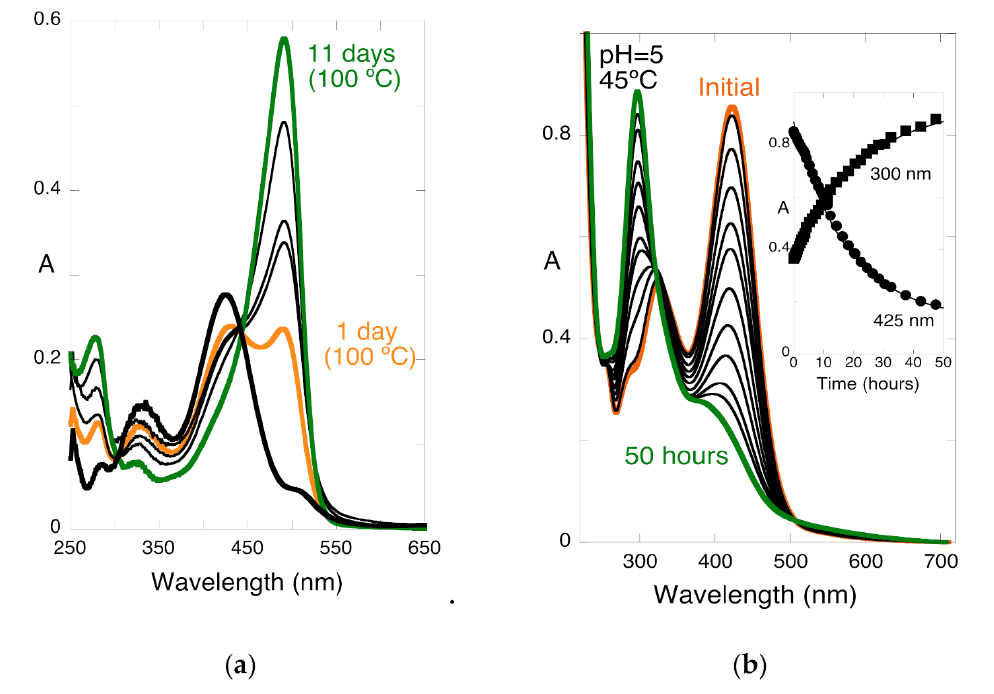
Figure 7. ( a ) Conversion of the trans -chalcone of riccionidin A in acetic acid saturated with HCl gas at 100 ◦ C. ( b ) Spectral variations of the trans- chalcone at pH = 5.0 in methanol:water (1:1) at 45 ◦ C, [Ct]= 5.0 × 10 − 5 M. The same behavior is observed in the pH range 1 < pH < 6. Adapted from [13]. It was possible to identify the species AH + , A , B , Cc , and Ct by HPLC/MS [13] before decomposition (Scheme 11a) confirming that the multistate of species is the same as that of anthocyanins (Scheme 11c) and 3-deoxyanthocyanins (Scheme 11b). Moreover, the degradation products of these three families appeared to be similar (Scheme